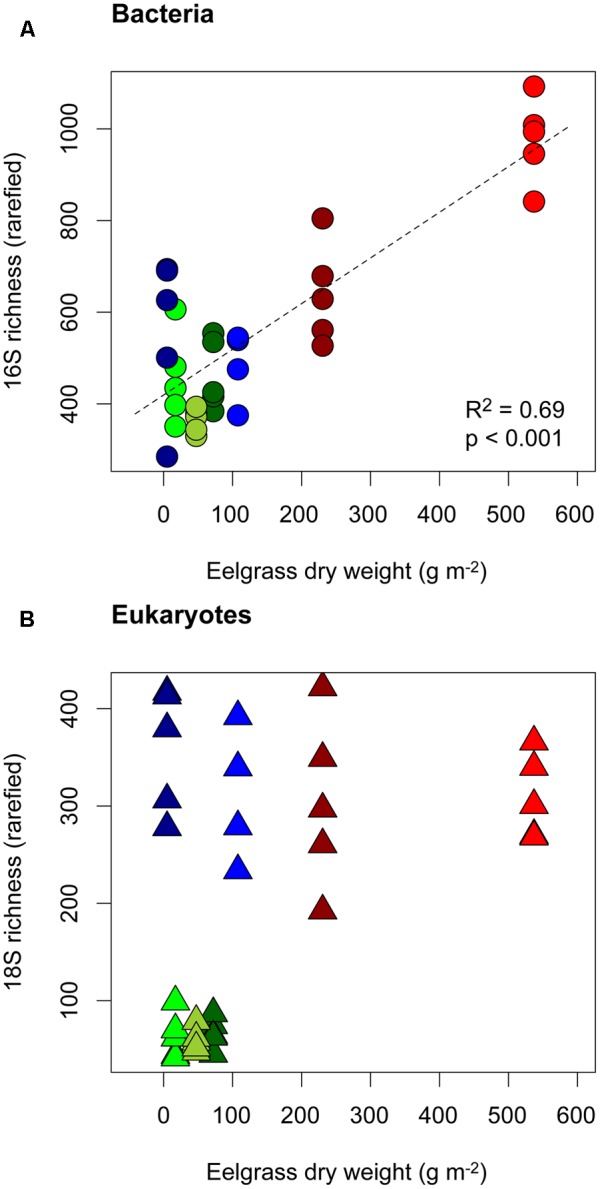
Richness of 16S (A) and 18S (B) rRNA gene sequence variants in relation to the biomass (dry weight) of Zostera marina at all sampling sites. Symbols and colors are the same as in Figure 1.